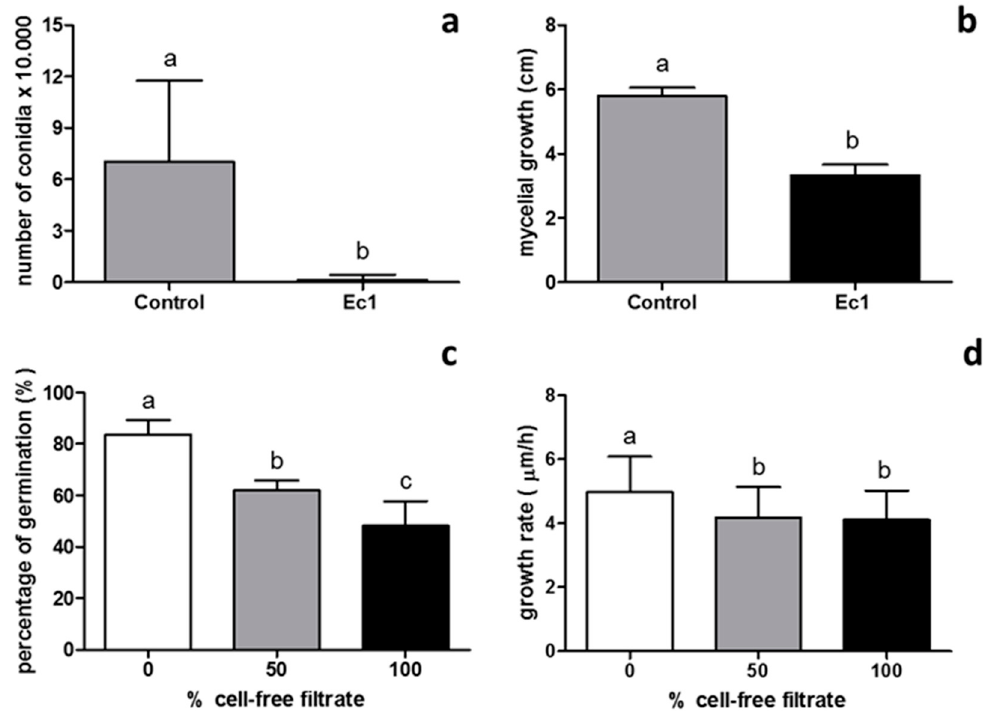
Figure 2. Antifungal activity of volatile and diffusible compounds secreted by the isolate Ec1 against B. cinerea . ( a ) Effect of volatile compounds secreted by Ec1 on sporulation of B. cinerea after 7 days of incubation at 22 °C. ( b ) Effect of diffusible compounds on mycelial growth of B. cinerea after 3 days of incubation at 22 °C. Gray bars represent B. cinerea control and black bars represent isolate Ec1 test treatment. ( c ) Effect of the cell-free filtrate obtained from Ec1 at different concentrations on germination of B. cinerea conidia after 4-h incubation. ( d ) Growth rate ( μ m/h) of the germ tube of B. cinerea after 4 h of incubation at different concentration of cell-free filtrates obtained from Ec1. Values represent the mean ± SD. a, b: A Student’s t-test and Mann Whitney test were completed. c, d: Analysis of variance (ANOVA) with Tukey’s test was carried out. Columns with different letters are significantly different ( p < 0.05).